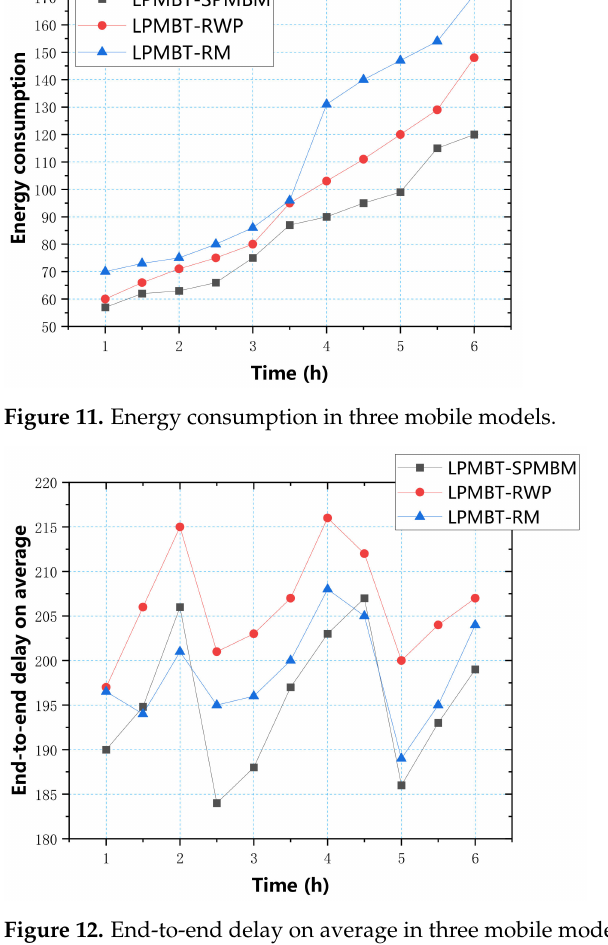
Figure 12. End-to-end delay on average in three mobile models.